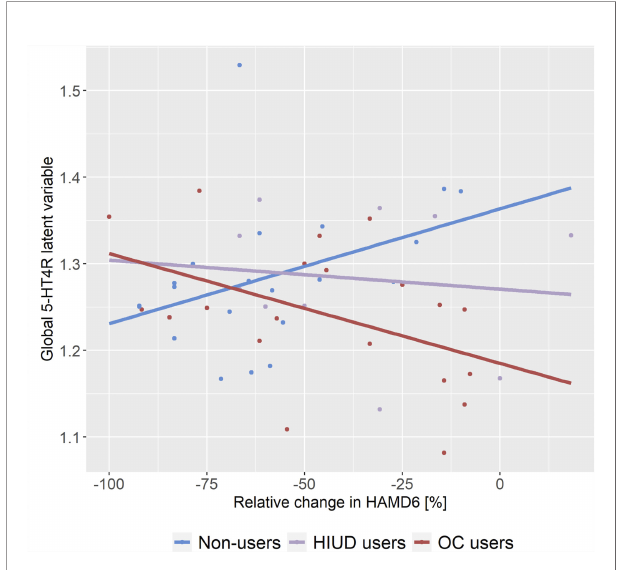
FIGURE 3 | Estimated global 5-HT4R latent variable summarizing the association between baseline global 5-HT4R brain binding and week eight antidepressant drug treatment response across the groups. The slopes are the association between baseline (un-medicated) 5-HT4R binding and change in Hamilton Depression Rating Scale 6 items (HAMD 6 ) in each group, respectively. A negative change in HAMD 6 mirrors an improvement of depressive symptoms. The slopes are 1.33x10 -2 (p adj =0.10) for the non- users, -3.34x10 -3 (p adj =0.75) for the hormonal intrauterine device (HIUD) users, and -1.27x10 -2 (p adj =0.07) for the oral contraceptive (OC)